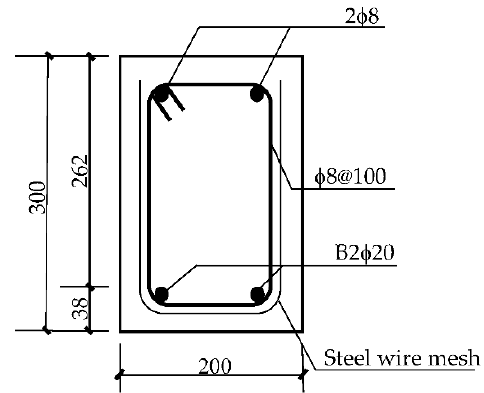
Table 4. Parameters of the test beams.